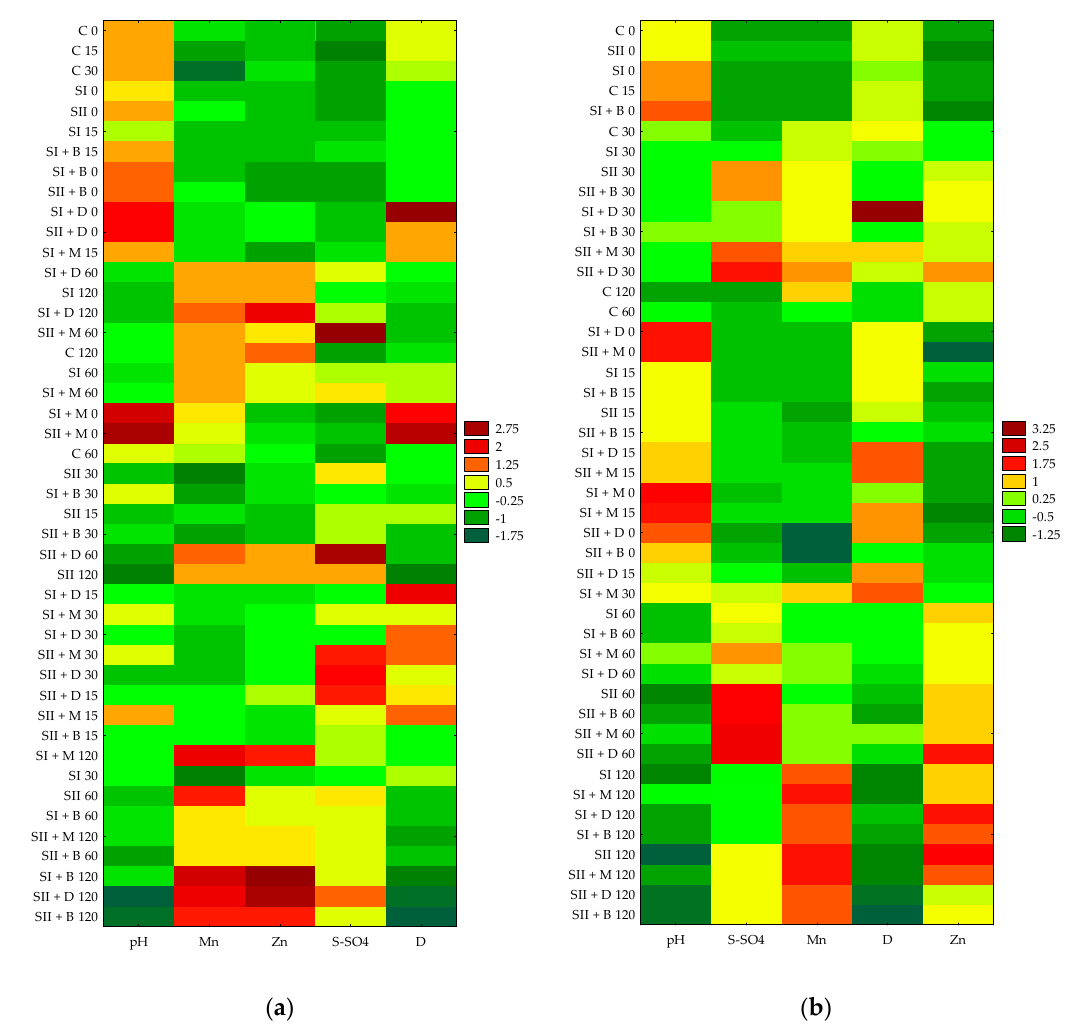
Figure 9. Heatmaps of selected soil parameters (pH, D activity, S-SO 4 , and Mn and Zn contents) in very light ( a ) and heavy soils ( b ).